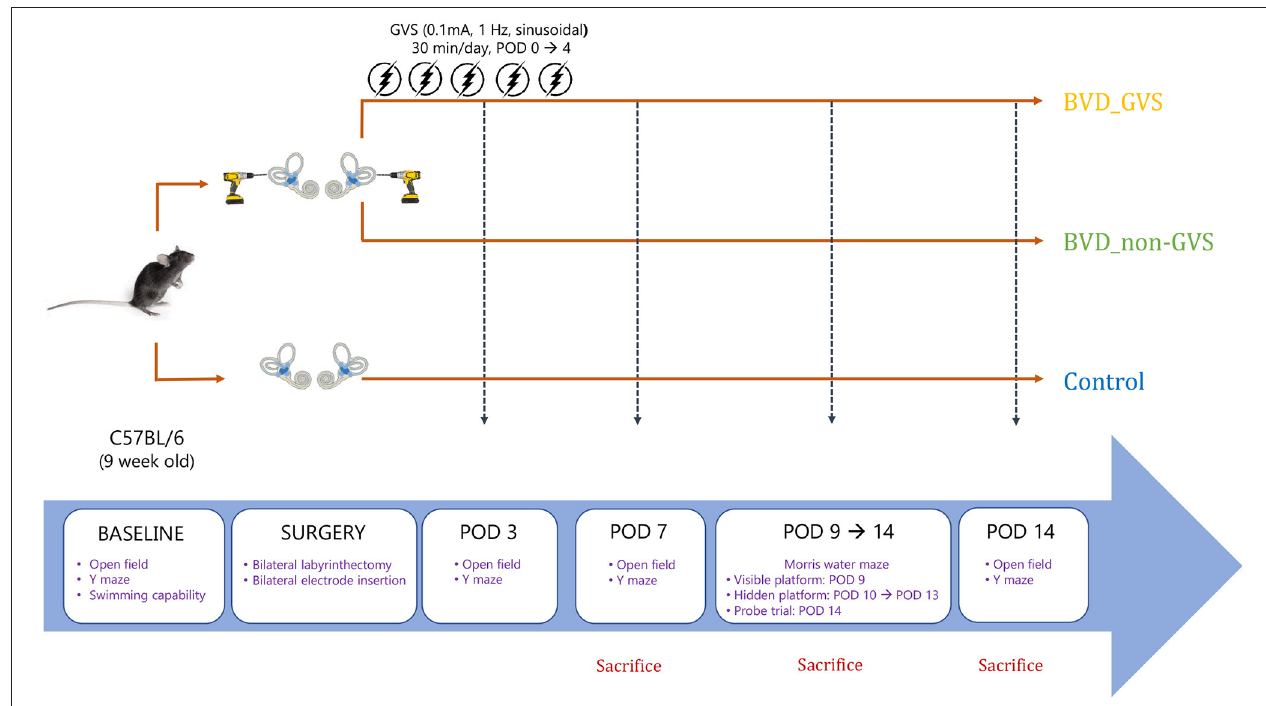
FIGURE 1 | A schematic representation of the experimental design and schedules for GVS application. BVD, bilateral vestibular deafferentation; GVS, galvanic vestibular stimulation; POD, postoperative day.